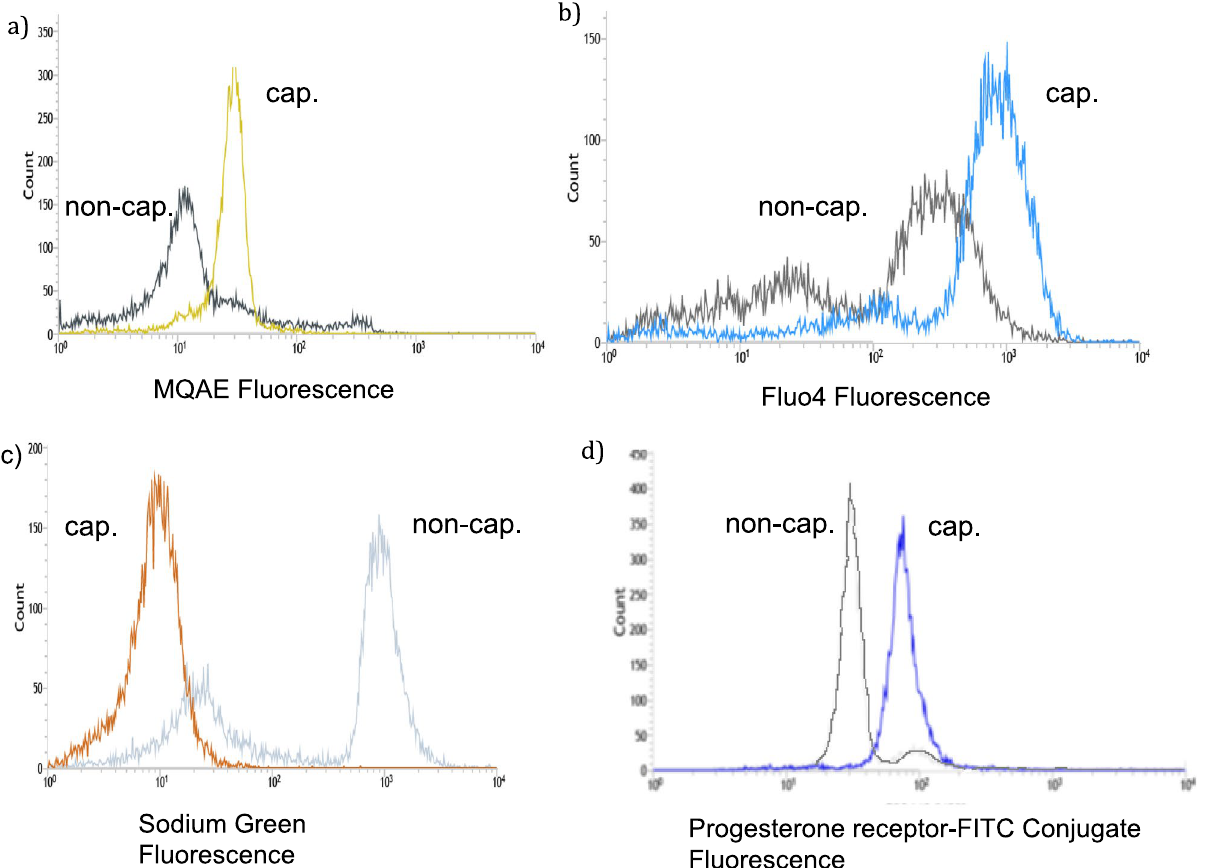
Figure 2. Representative example of FC histograms of capacitating and non-capacitating spermatozoa (donor 3), stained by four different fluorescent dyes. The Y-axis represents the number of spermatozoa labelled by the corresponding fluorescence depicted in the X-axis. ( a ) MQAE: black non-capacitated, yellow capacitated; ( b ) Fluo4: grey non-capacitated, blue capacitated; ( c ) sodium green staining: grey non-capacitated, orange capacitated; ( d ) progesterone-FITC staining: grey non-capacitated, blue be increased by sorting spermatozoa stained with the fluo4-dye, this difference was statistically not significant because of high variability of the sorting results (p = 0.109). Considering all differences being significant and consistent enough to allow the separation of capacitating spermatozoa from non-capacitating spermatozoa with FACS, the most pronounced difference was achieved with the sodium green dye. Thus, the sodium green dye was used to distinguish between capacitating and non-capacitating spermatozoa of three men heterozygous for Phe508del (Fig. 1, dark green columns). More spermatozoa were stained with the sodium green dye, when they were incubated in capacitating medium than in non-capacitating medium (p = 0.042). In one patient, the sorted spermatozoa were subjected to single cell PCR to detect the presence of Phe508del. Among the capacitating spermatozoa (weak sodium green signal), 6 out of 38 (16%) spermatozoa carried the Phe508del-variant, 7 out of 38 (18%) did not and in 25 (66%) spermatozoa no signal was detected. Among the non-capacitating spermatozoa (strong sodium green signal), 14/48 (29%) spermatozoa carried the genetic variant, 7/48 (15%) did not and in 27 (56%) spermatozoa no signal was detected. Inhibition of capacitation of human spermatozoa through inhibition of CFTR‑ion chan‑ nel.